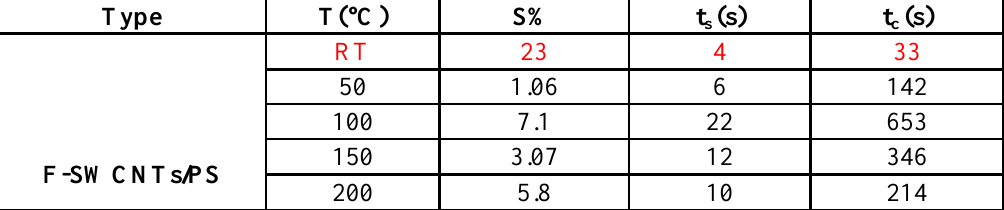
and Recovery time (tc) of F-SWCNTs/Porous s) gas at different temperature. 2